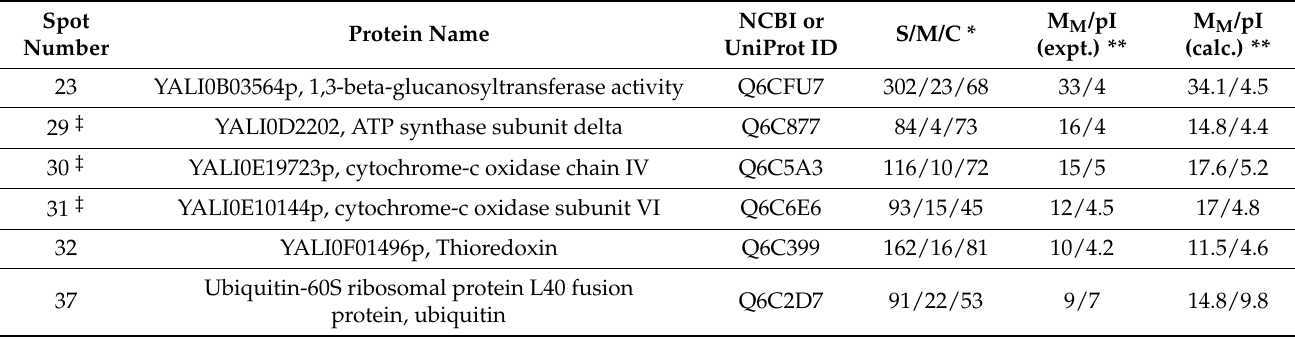
Table 4. The list of down-regulated proteins in response to alkaline stress in the Y. lipolytica yeast using mass spectrometry (MALDI-TOF MS and MS/MS) under alkaline